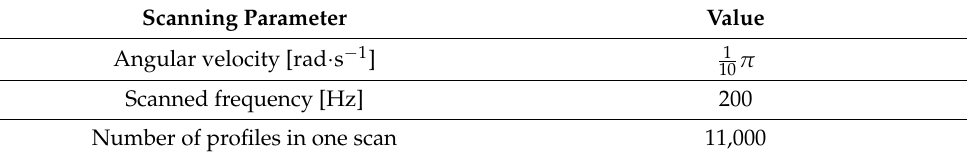
Figure 5. Data visualization of scanned shaft surfaces, measuring 1, file “k1.csv” ( A )—3D, ( B ) scanned surfaces projected to 2D—plane XZ. Table 2. Scanning